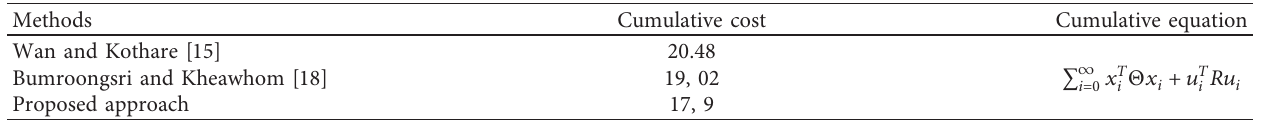
Table 3: Cumulative cost in Example